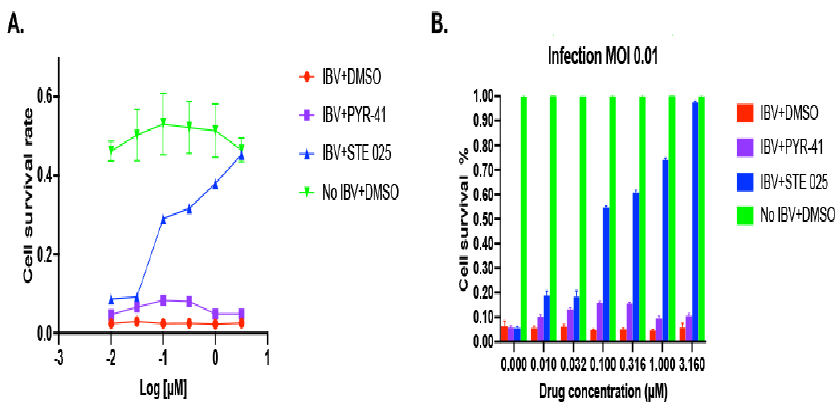
Figure 2. Cell death induced by IBV infection can be rescued by the SUMOylation-specific inhibitor, STE025. ( A ) The MDCK cells were incubated overnight with the SUMOylation-specific inhibitor, STE025, before infection with IBV for 3 days. The cell survival was determined using a Neutral Red assay. The death of MDCK cells infected with IBV was completely rescued with the STE025, but not PTY-41. ( B ) The percentages of cell rescue were calculated according to the control group cells with no virus infection.